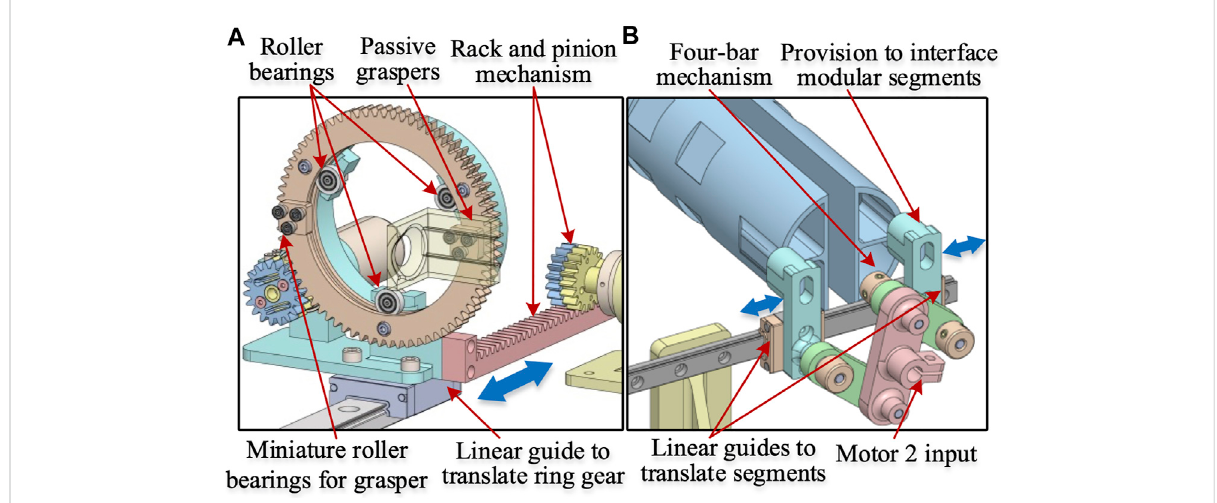
FIGURE 3 Subassemblies of the haptic grasper (A) Ring gear mechanism (B) Four-bar mechanism for moving modular segments. The ring gear mechanism holds the passive graspers through miniature roller bearings that allow the lateral movement of the graspers (grasping DoF). Also, the other roller bearings allow the rotary DoF. The 4-bar mechanism is attached to the modular segments through a provision component that moves along with the passive graspers providing the grasping